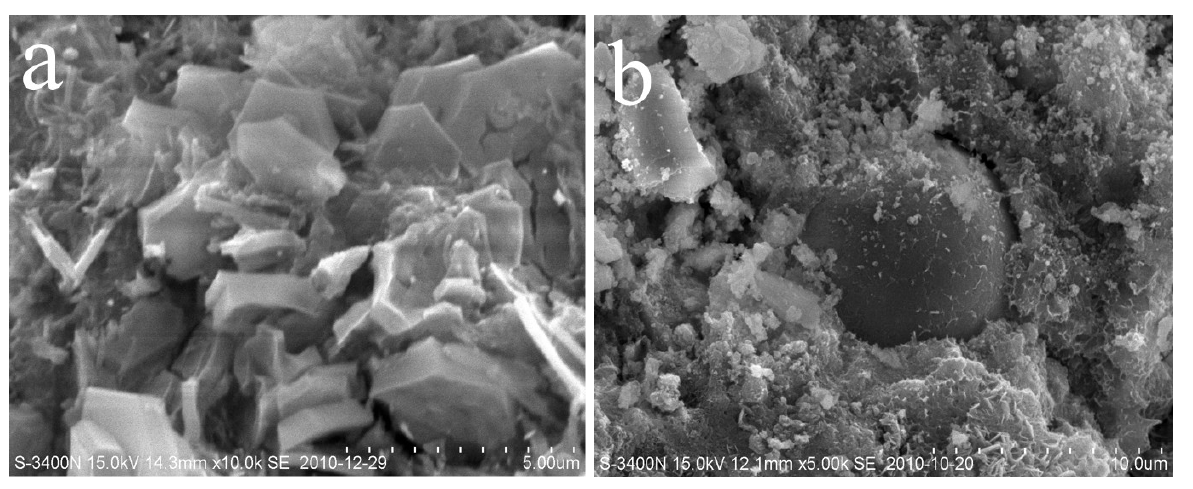
Figure 6. Microscopic morphology of concrete at the immersion age of 150 days as observed by SEM: ( a ) PC47; ( b )